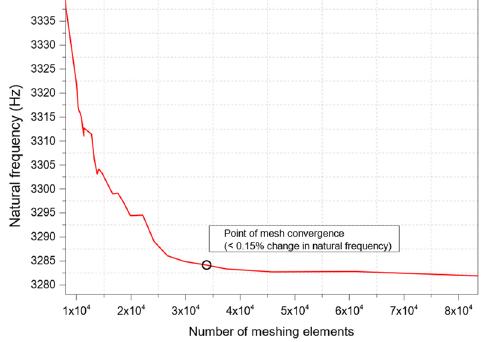
Figure 6. Mesh convergence study for MEMS accelerometer.